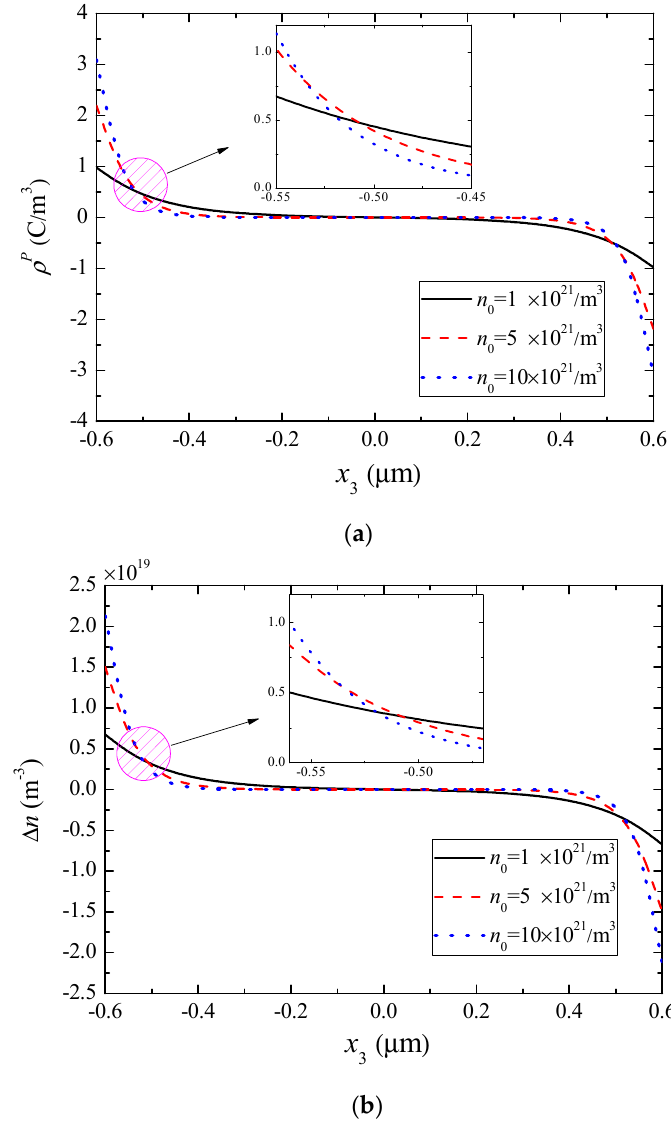
Figure 7. Piezoelectrically induced electric fields for different n 0 when 4 potential, ( b ) electric field, ( c ) electric displacement.